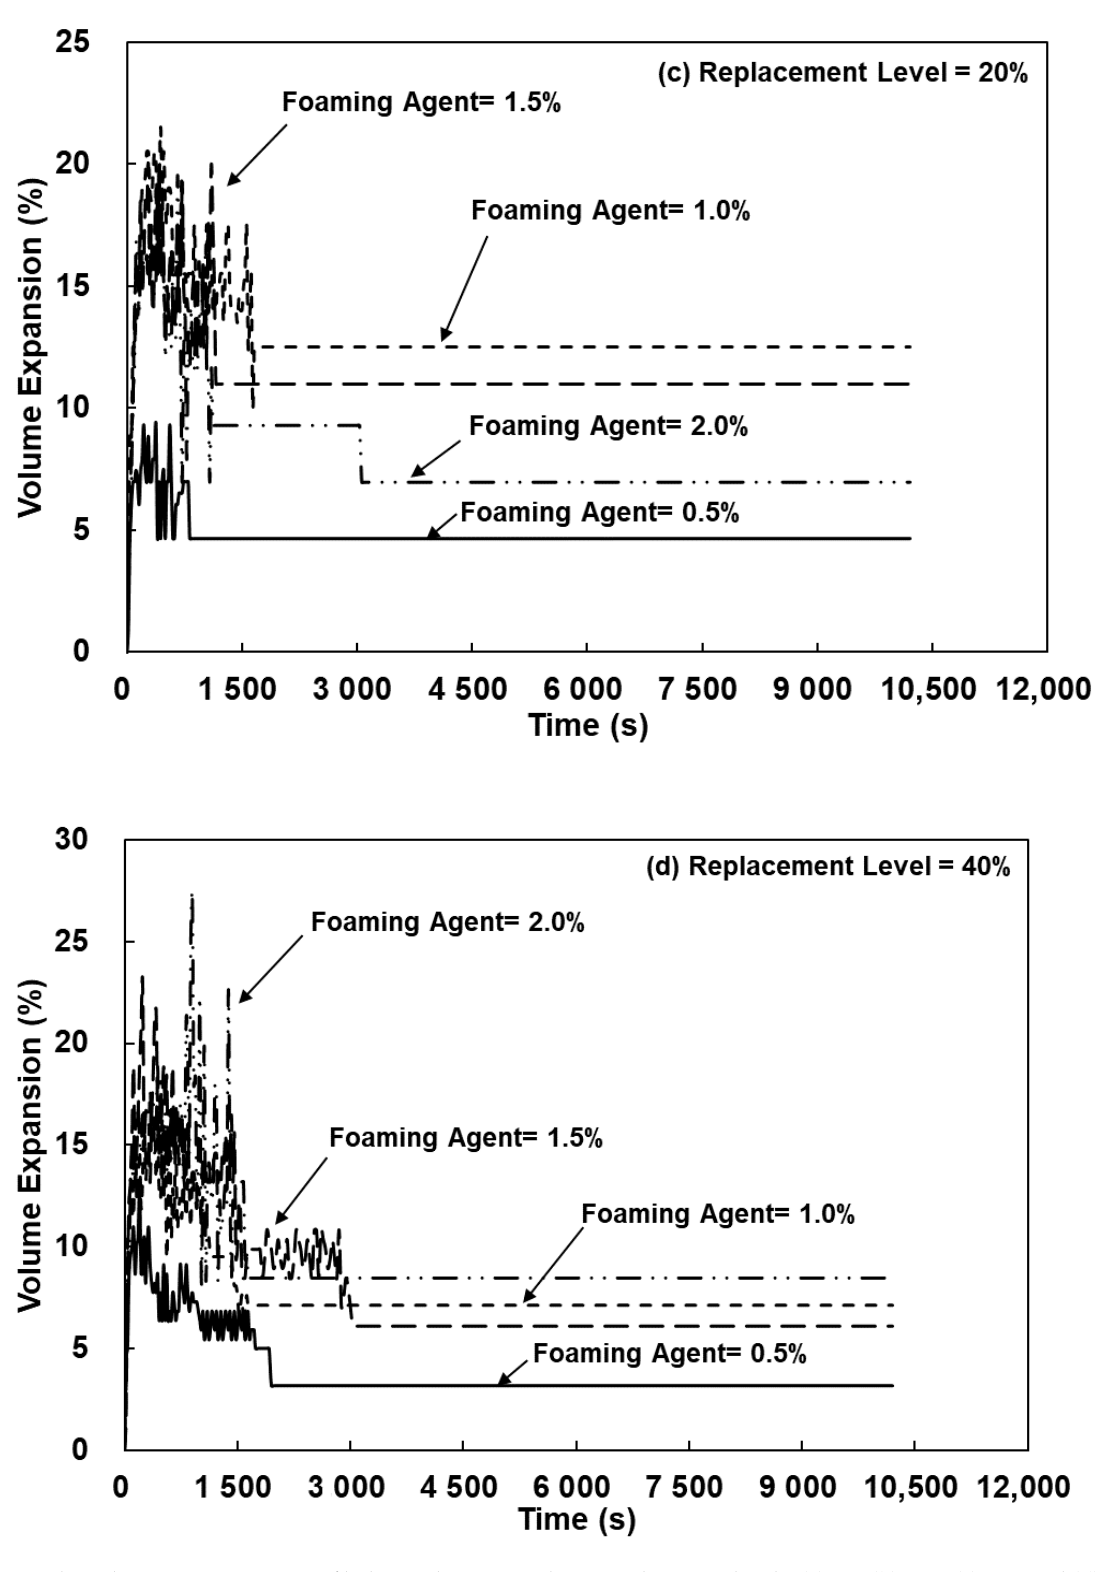
Figure 9. The volume expansion ratio of lightweight FGPs with SCS replacement levels. ( a ) 0%; ( b ) 10%; ( c ) 20% and ( d ) 40%